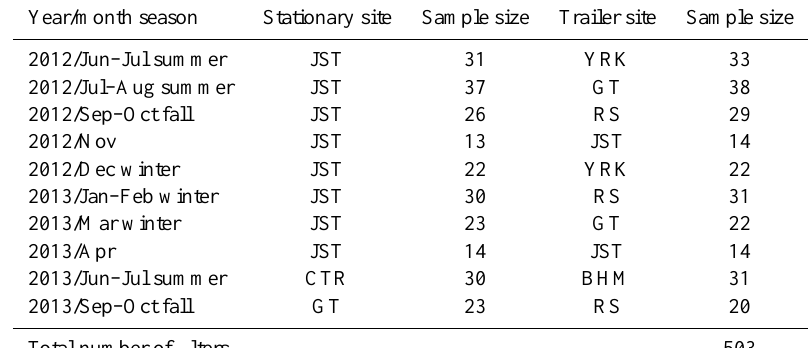
Table 1. Sampling schedule and number of Hi-Vol filters collected at each site from June 2012 to September